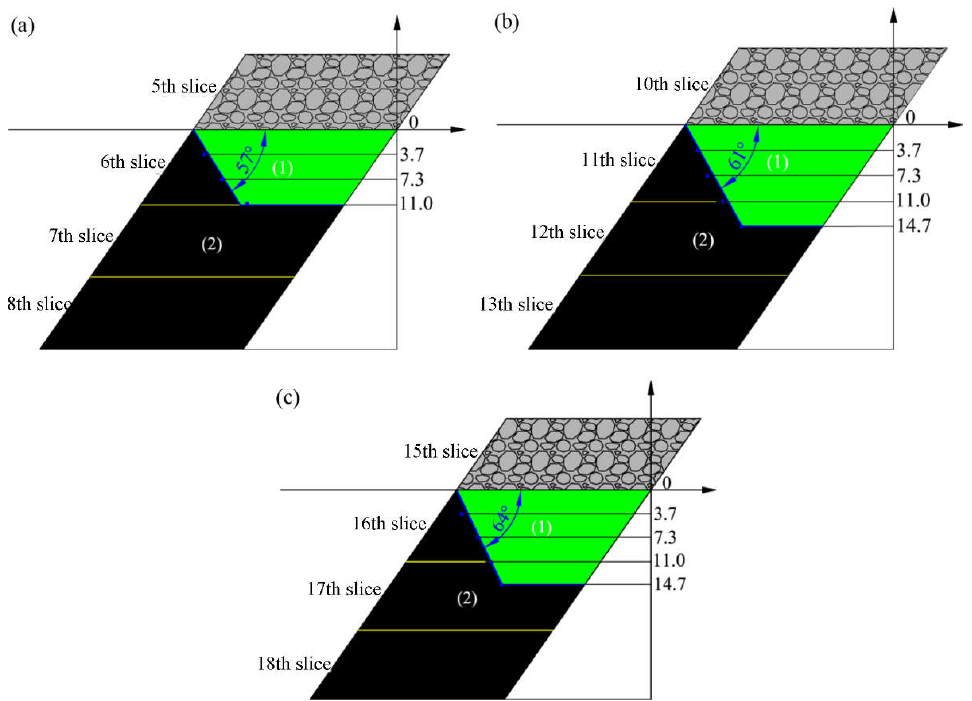
Figure 12. The effective pressure relief ranges in the coal below the goaf: ( a ) the 5th slice, ( b ) the 10th slice and ( c ) the 15th slice. In each figure: (1) denotes the effective pressure relief zone, and (2) denotes the stress concentration zone.